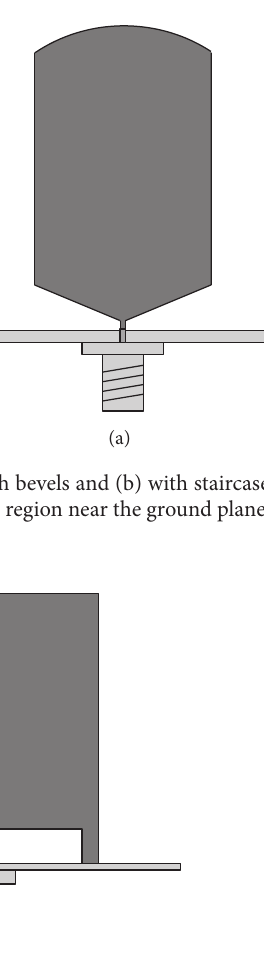
Figure 9: A rectangular monopole with a shorting post. Dark gray monopole and medium gray ground plane